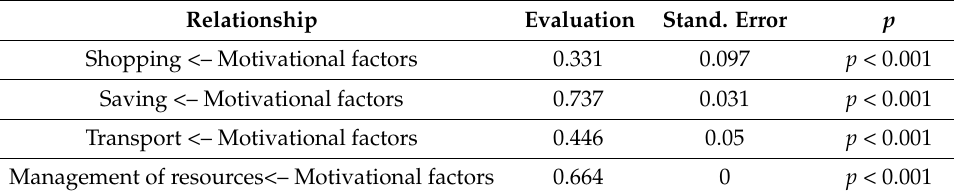
Table 11. Estimated parameters of the recursive model (Model